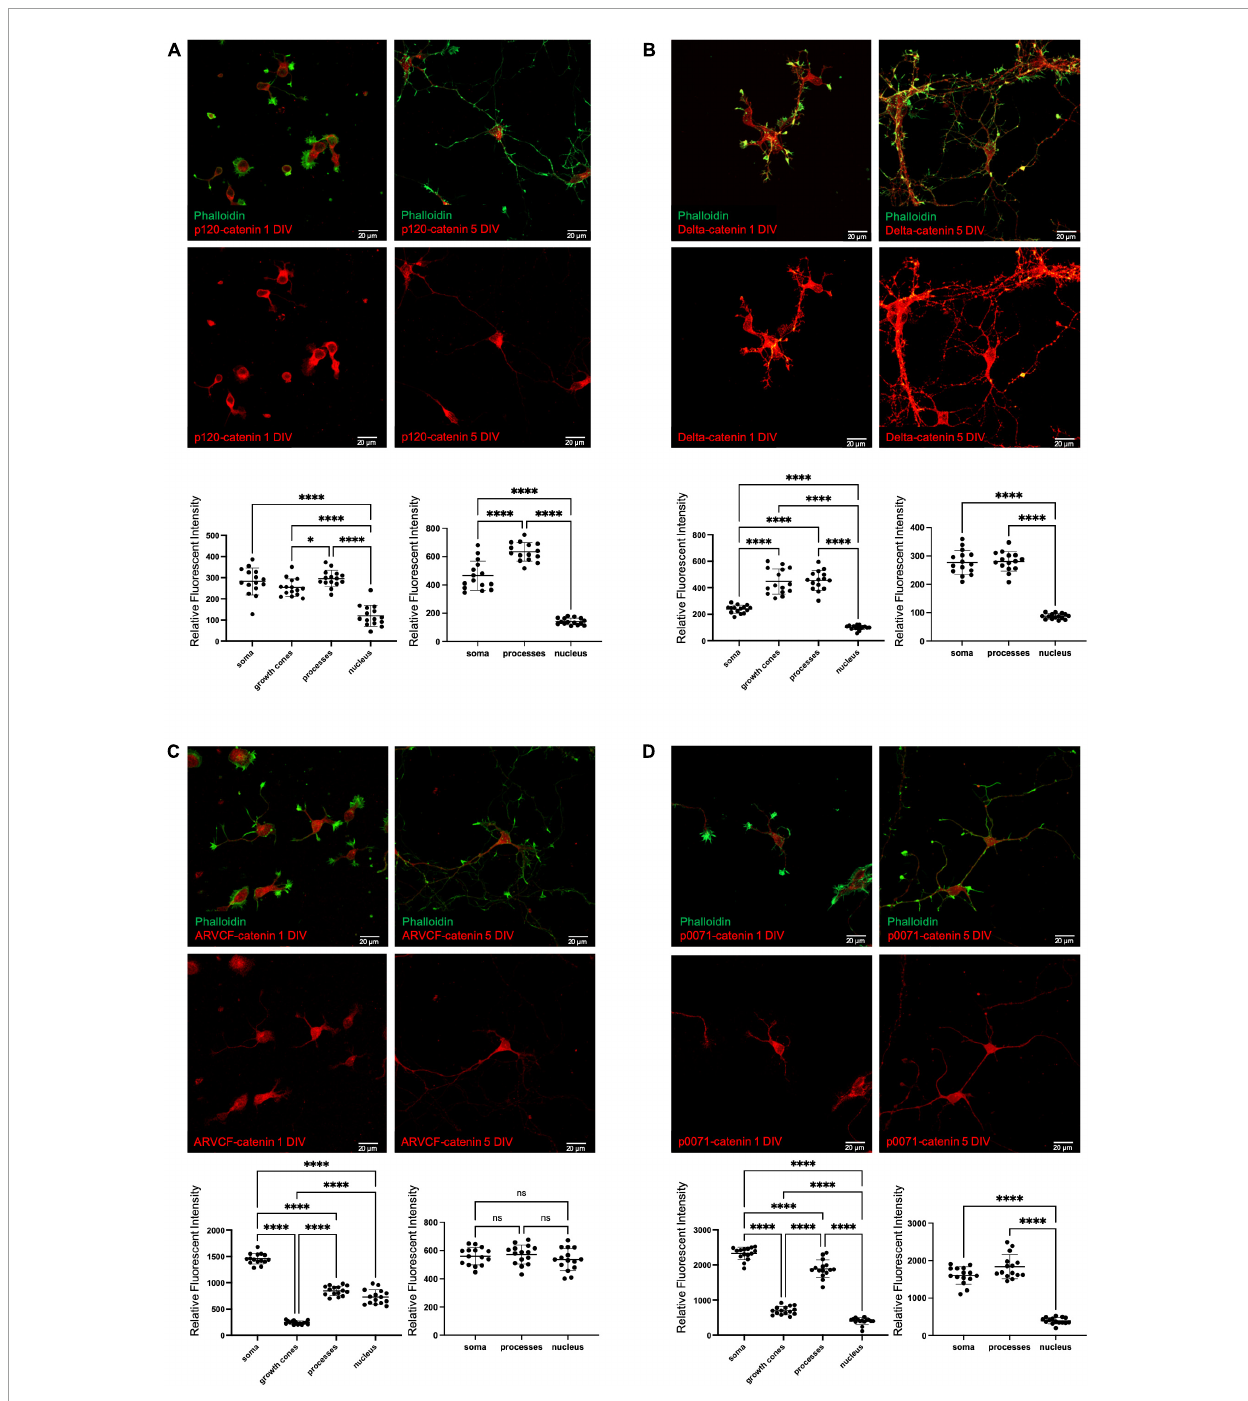
FIGURE2 Endogenous localization of p120-subfamily catenins in primary neurons. Endogenous localization of (A) p120-catenin; (B) delta-catenin; (C) ARVCF-catenin; (D) p0071-catenin in primary rat hippocampal neurons at 1 DIV and 5 DIV. Relative fluorescent intensity in the soma growth cones, processes, and nucleus is shown below each example image for 1 DIV (left) and 5 DIV (right). Cells were co-stained with Phalloidin and DAPI to help visualize growth cones and nuclei for quantification, but for clarity these stains are not pictured in example images. Statistical significance was determined using a two-way Brown-Forsythe and Welch ANOVA tests with Dunnett’s T3 multiple comparisons post-hoc test. Significance was assigned at P < 0.05 for *, and P < 0.0001 for ****, and ns for non-significant. N = 15 neurons from three biological replicates for each catenin at each DIV. Graph values show mean and standard